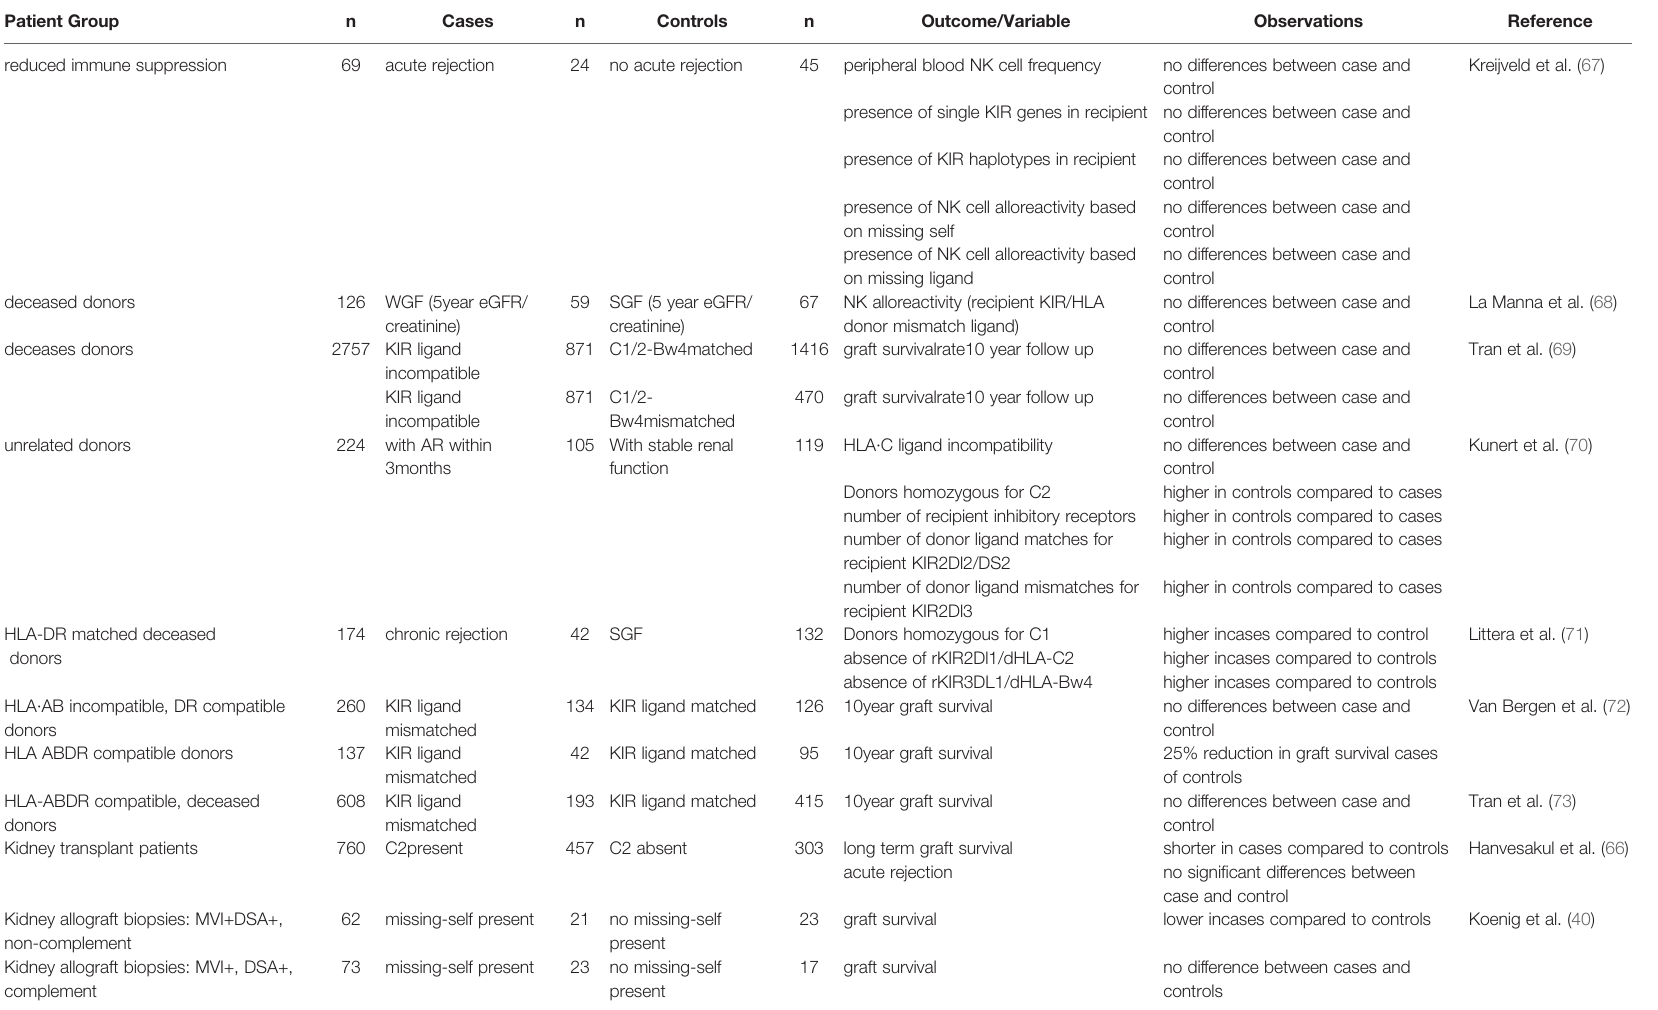
TABLE 1 | Overview of published studies investigating the impact of KIR-ligand matching and mismatching on graft survival and graft rejection after kidney